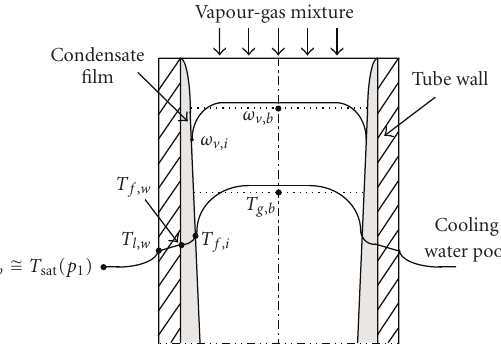
Figure 1: PANTHERS-PCC test facility.